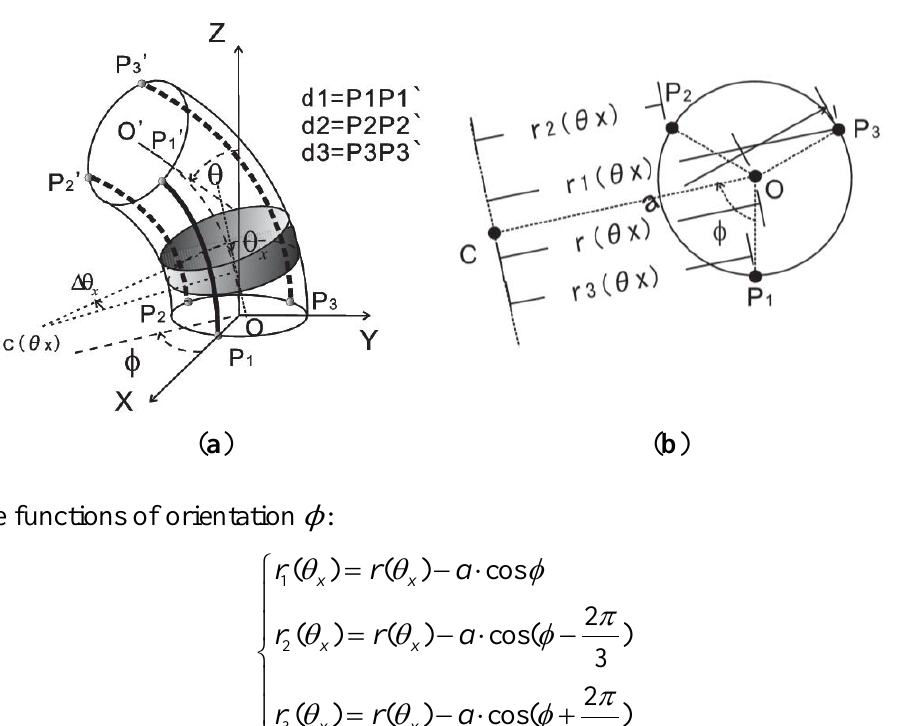
Figure 3. Geometric analysis ( a ) Working coordinate system of sensor; ( b ) Calculation of bending radius of three lateral